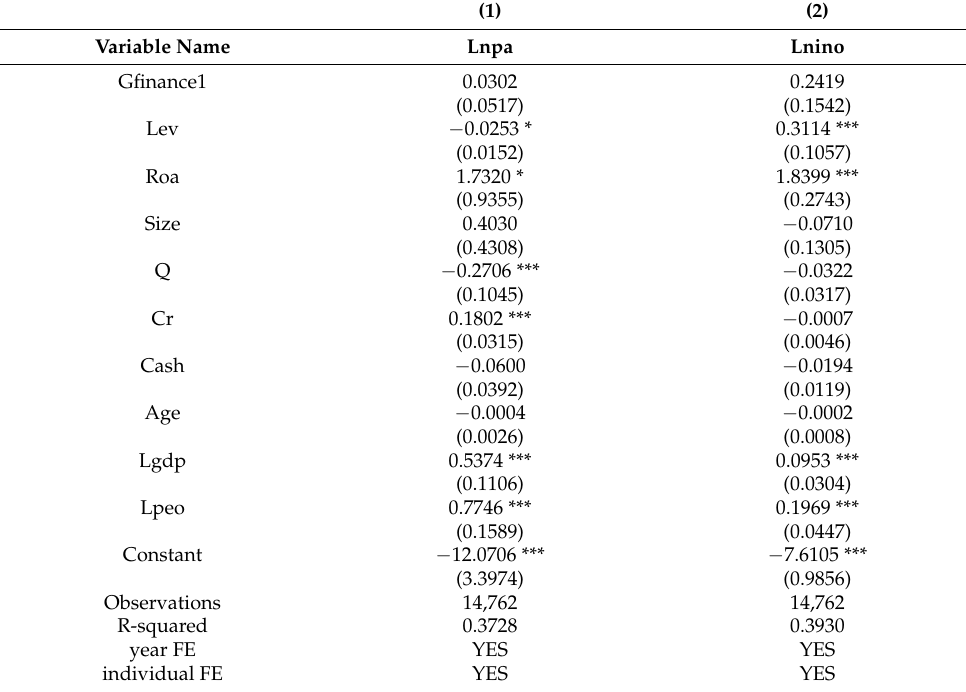
Table 5. Counterfactual